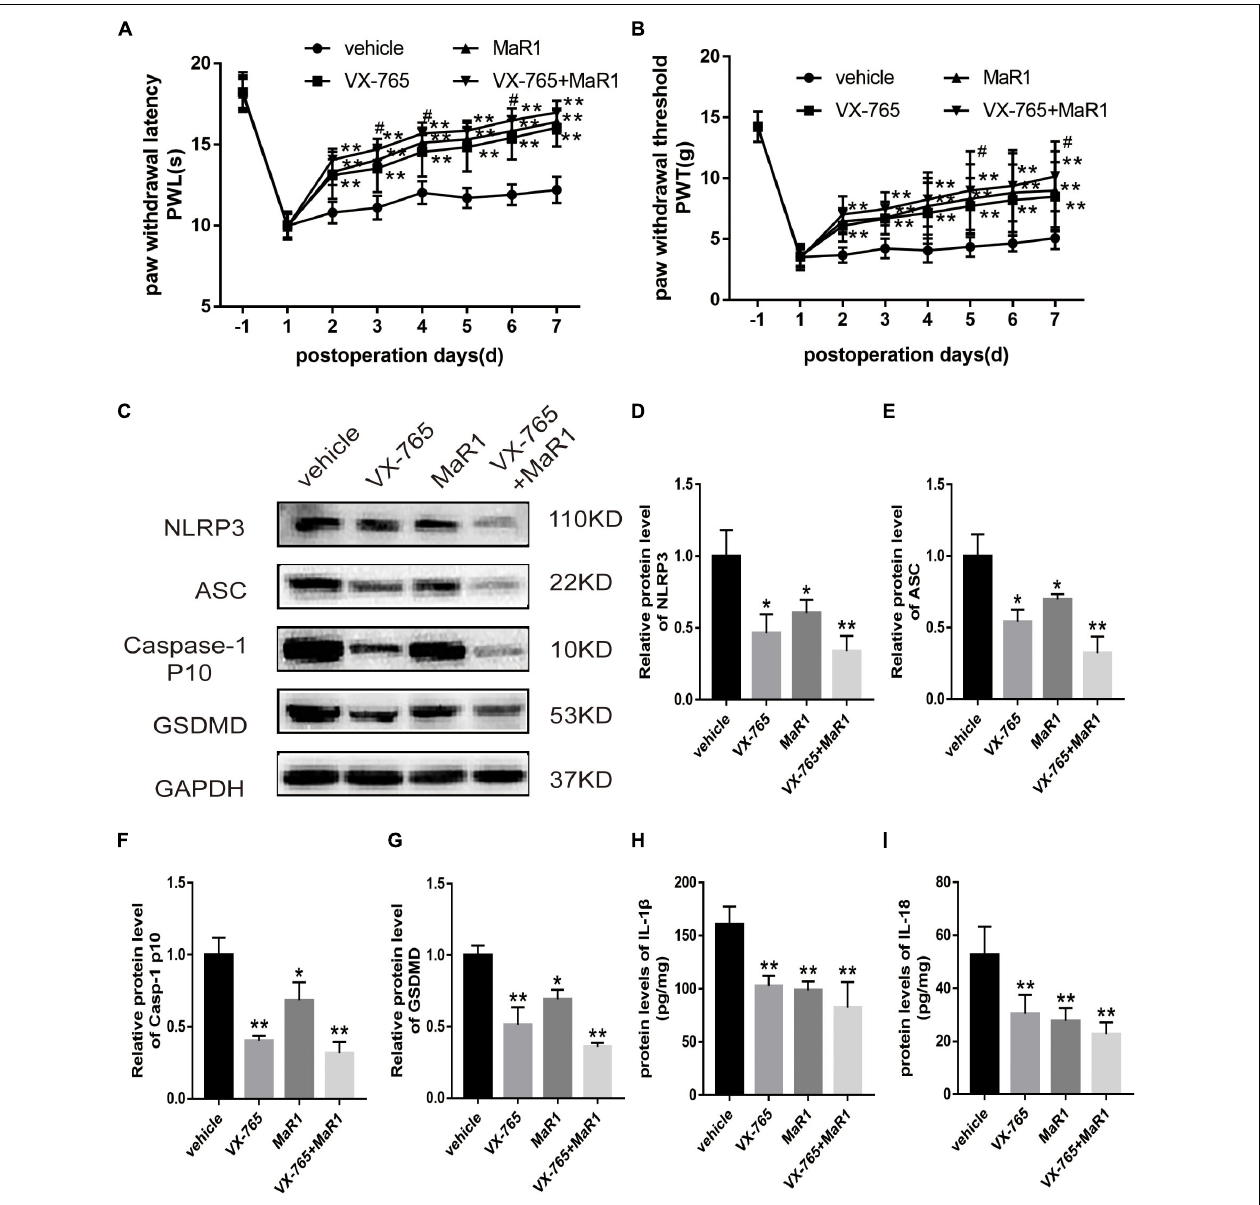
FIGURE 6 | MaR1 attenuated inflammatory response by inhibiting NLRP3 inflammasome activation ( n = 6/group). The operative rats were injected with Caspase-1 inhibitor (VX-765) intraperitoneally with or without intrathecal administration of MaR1. (A,B) The mechanical and thermal hypersensitivity were assessed to evaluate the analgesic effect. (C–G) The protein expressions of NLRP3 inflammasome and pyroptosis-related indicators were analyzed by Western blot. (H,I) The IL-1 β and IL-18 protein levels were tested by ELISA. Data are given as the mean ± SD (** P < 0.01 versus the vehicle group; * P < 0.05 versus the vehicle group; # P < 0.05 versus the VX-765